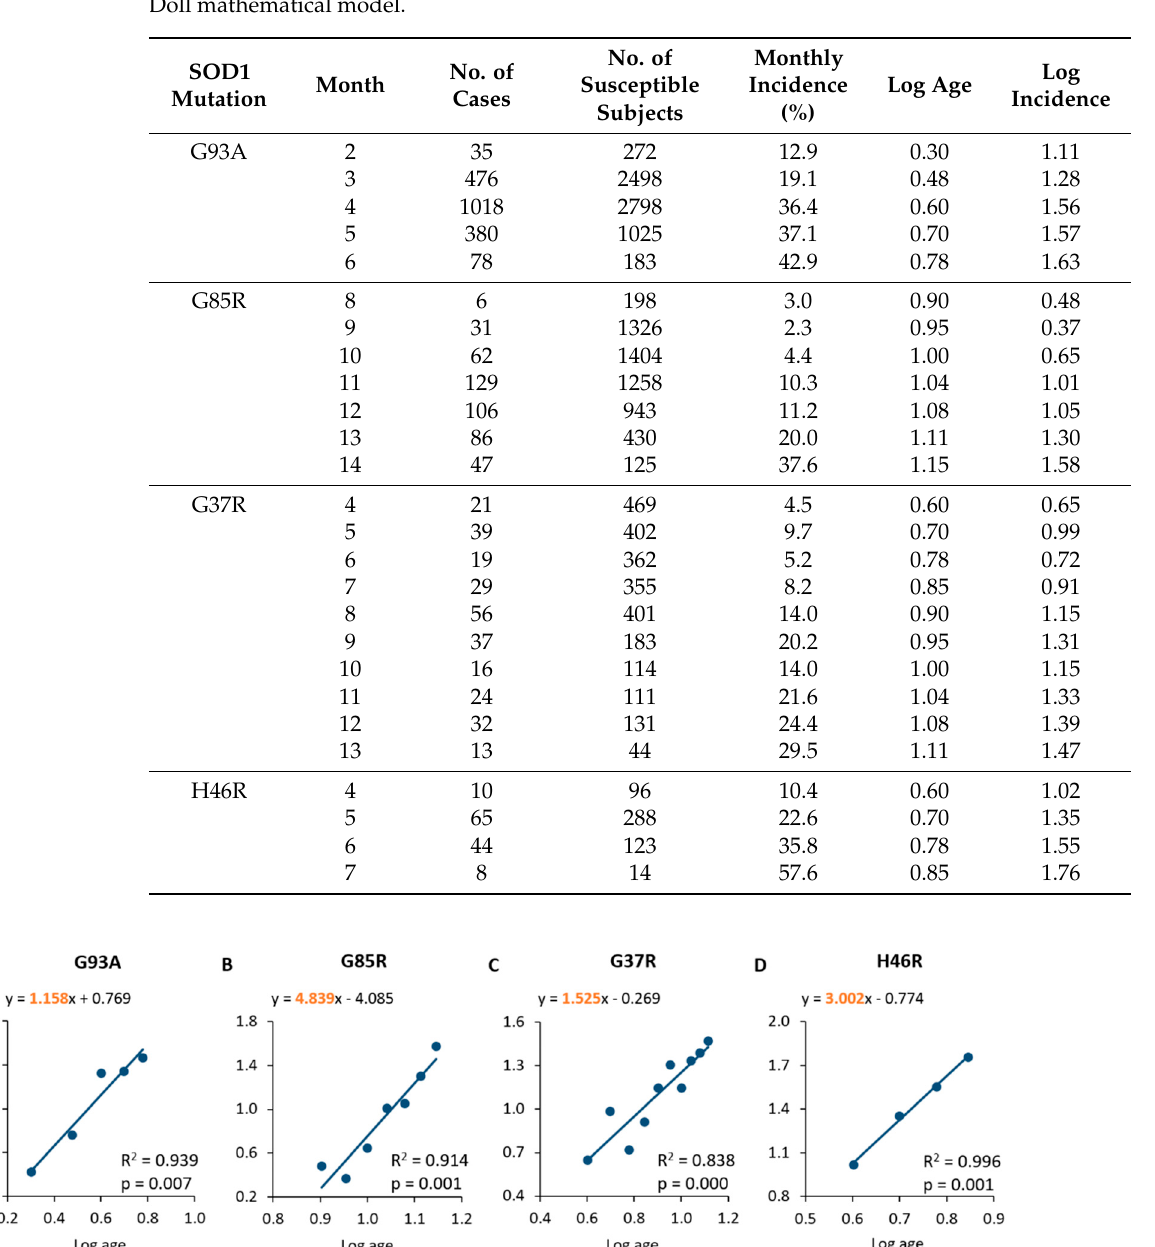
Table 2. Incidence data calculated for each SOD1 mutation, for the application of the Armitage and Doll mathematical model.